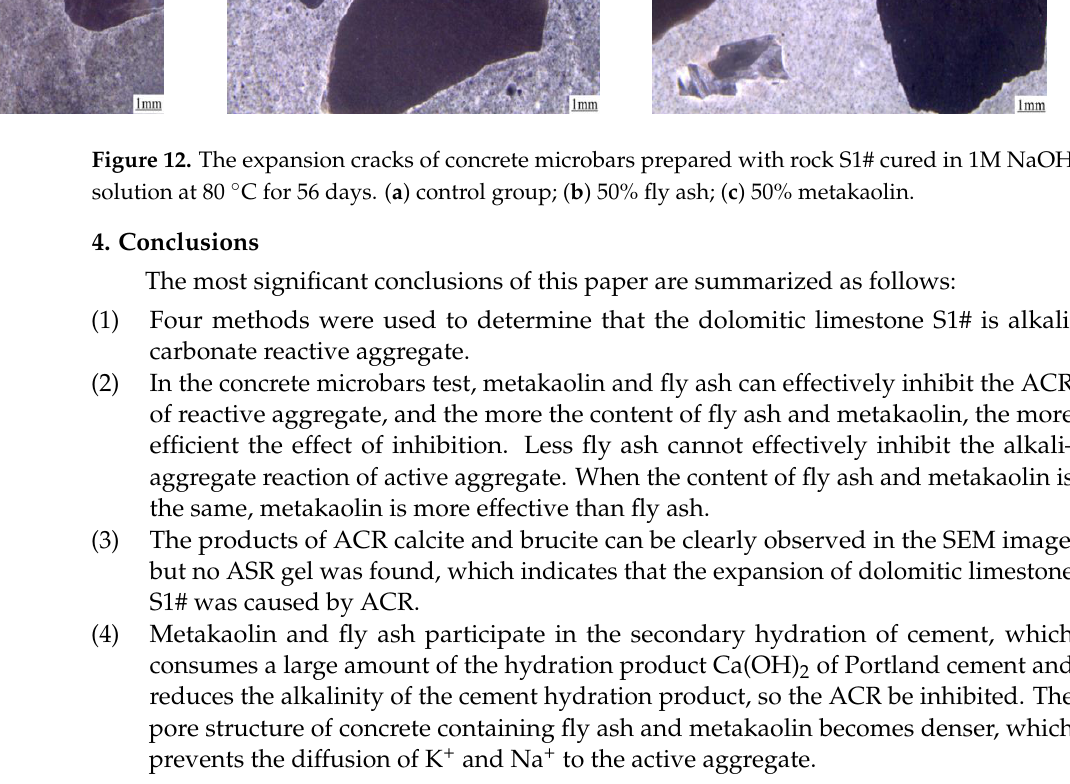
Figure 12. The expansion cracks of concrete microbars prepared with rock S1# cured in 1M NaOH solution at 80 ° C for 56 days. ( a ) control group; ( b ) 50% fly ash; ( c ) 50% metakaolin.